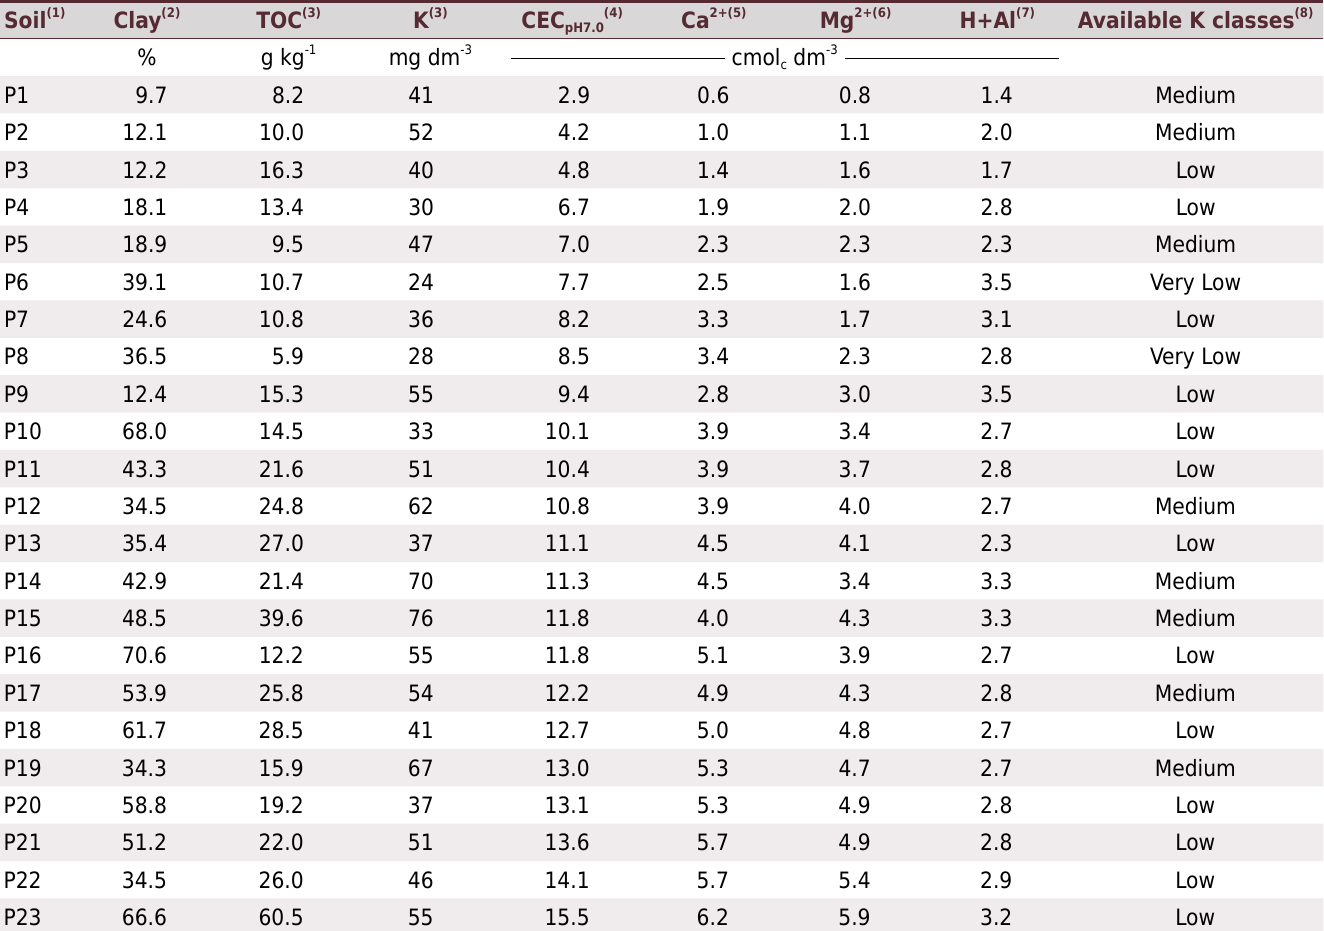
Table 1. Classification and characterization of soils samples collected from the 0.00–0.20 m soil layer in the Rio Grande do Sul and Santa Catarina states, Southern Brazil Soil